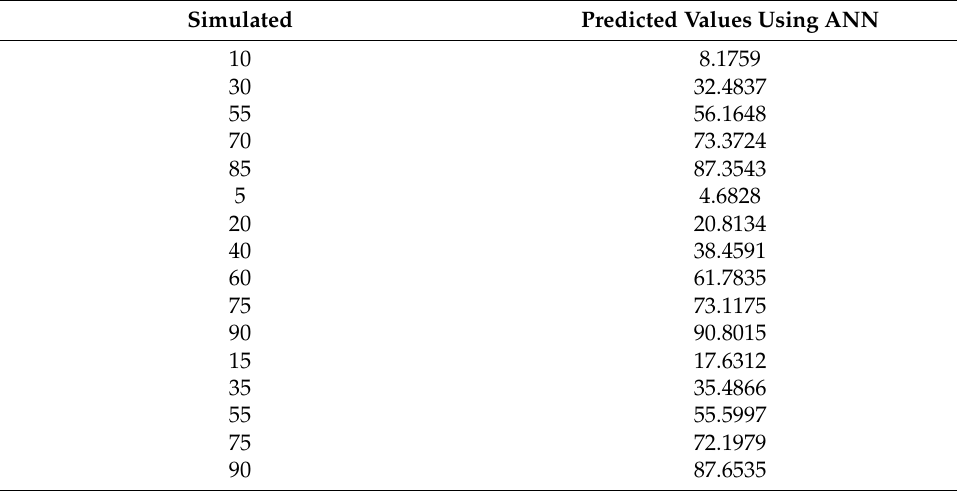
Table 5. Simulated and predicted values for volumetric